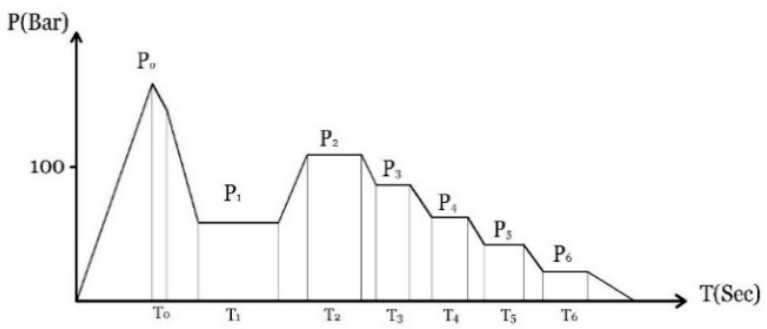
Figure 2. Hot press cycle graph.